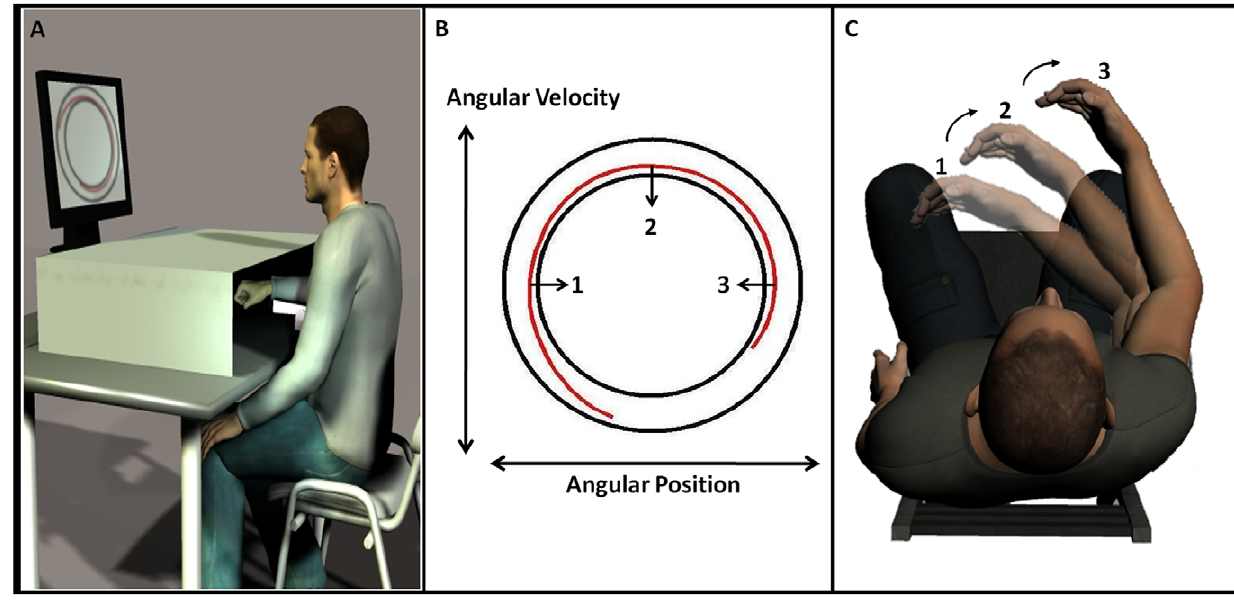
Figure 1. Experimental setup. (A) The experimental apparatus illustrated. The participant’s forearm is placed on a forearm support, allowing one- dimensional horizontal movements. The forearm is occluded from view, and visual feedback of the movement is given on the screen, in the form of a phase-plane display: the black ellipses represent the required limits of the movement’s amplitude and speed and the red line represents the trace of the participant’s movement on the phase plane (B) The phase-plane display, showing angular velocity vs. angular. The area between the two black ellipses is the region within which participants are required to maintain the trace of their movement. The red trace corresponds to the participant’s movement in the phase plane. The numbers ‘‘1’’ and ‘‘3’’ represent the maximum flexion and extension, respectively, the number ‘‘2’’ represents the location where the movement speed peaks (C) A top view of the participant’s forearm at three points along the movement trajectory (the numbers 1–3 correspond to the phase-plane locations marked in panel